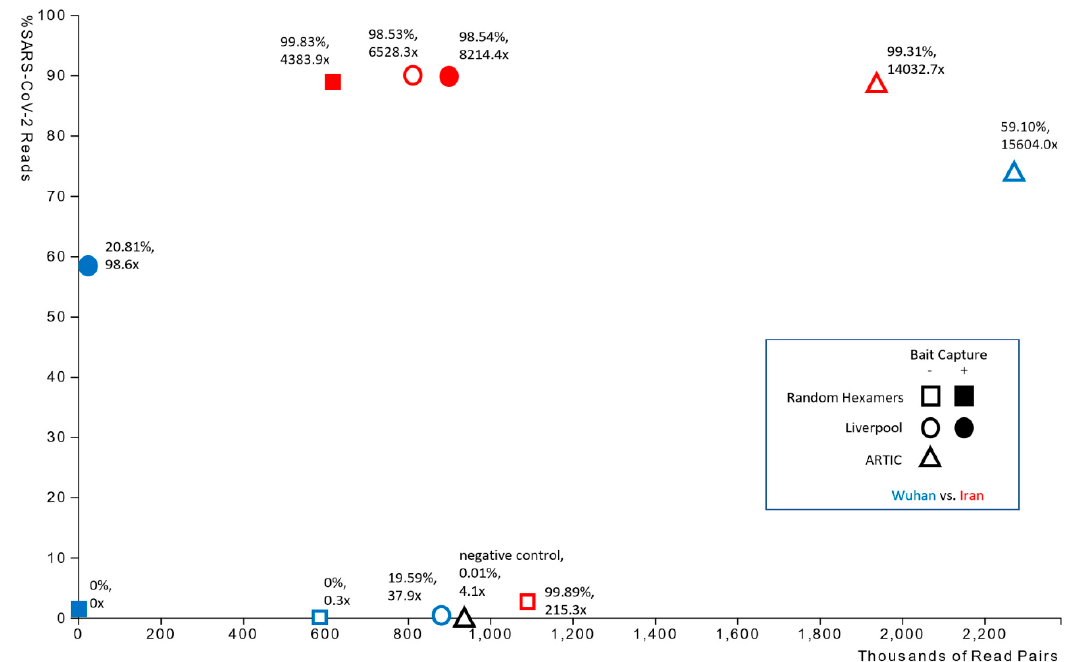
Figure 1. Plot showing the percent of sequencing reads mapping to the SARS-CoV-2 reference genome against the total number of paired reads acquired from each library preparation. Each data point is additionally labelled with a percent fraction and average read coverage of the SARS-CoV-2 genome.